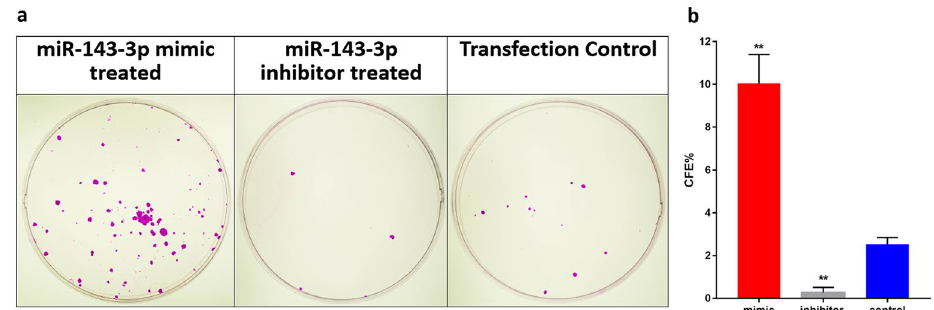
Figure 4. Colony forming potential of hsa-miR-143-3p transfected cells. ( a ) Representative Rhodamine B stained limbal epithelial cell colonies after 12 days of culture in the three groups: hsa-miR-143-3p mimic, inhibitor and control transfected cells. ( b ) The bar graph representing the colony forming efficiency of the cells in the three groups. ** P < 0.001.